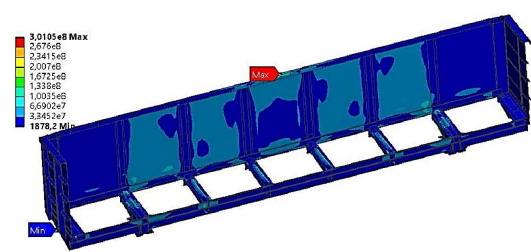
Figure 7. Fragment of a finite element model of a modernized gondola car